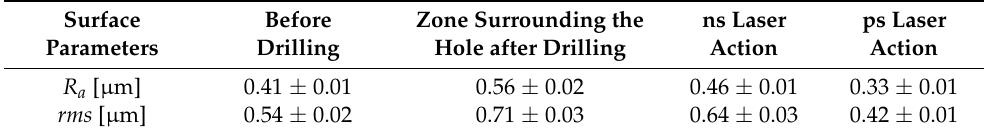
Table 2. Surface characteristics of the basic material (BM) and areas around the holes treated with picosecond laser and nanosecond laser irradiation.